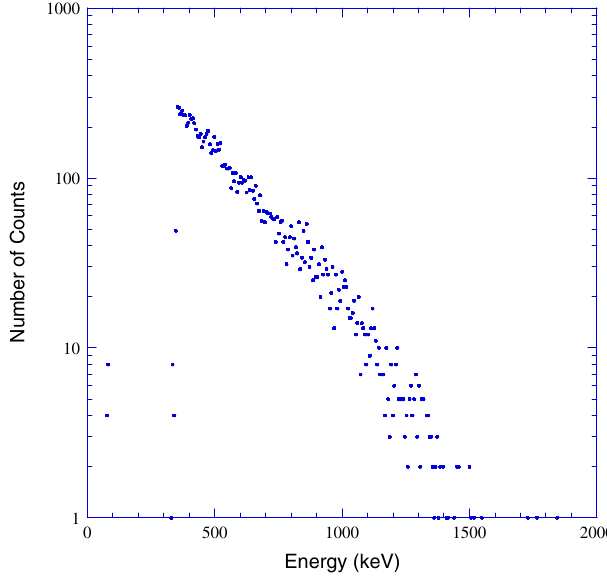
FIG. 6. Number of photons versus photon energy for experi- ment runs at 250 mW rf power. The mean energy of all data points at N ph ¼ 1 is 1449 keV.